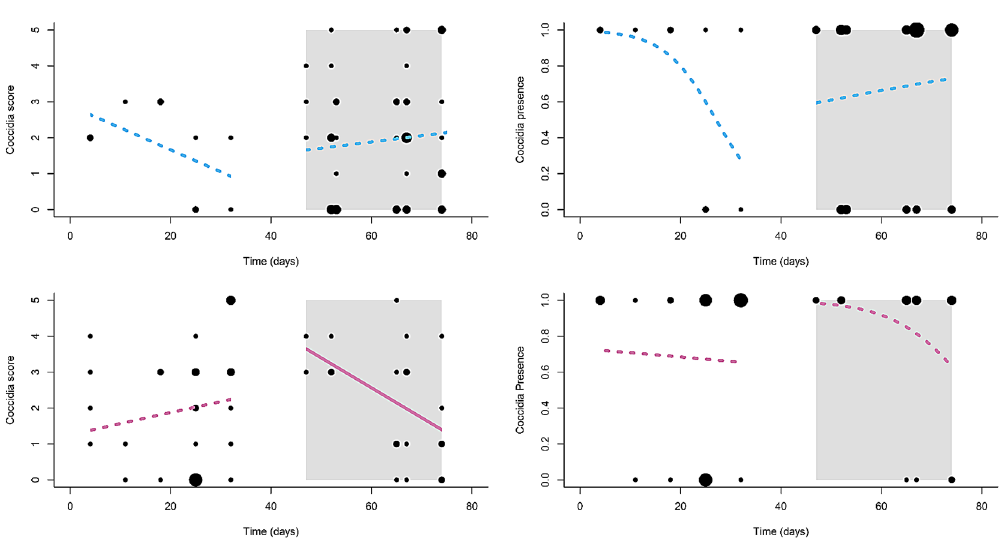
Figure 2. Scatterplots showing temporal variation in coccidiosis in males (blue lines) and females (pink lines) from our urban study site on the different feeder treatments (clean vs. dirty): ( a ) coccidia severity (shown as integer scores from 0 to 5), and ( b ) coccidia presence. Dirty-treatment data are shown inside the gray boxes, whereas clean-treatment data are shown against the white background. Point size is proportional to the number of overlapping observations. Solid lines denote slopes that were statistically significant different from zero, whereas dashed lines signify slopes that did not differ from zero. The figure was drawn using R software 33